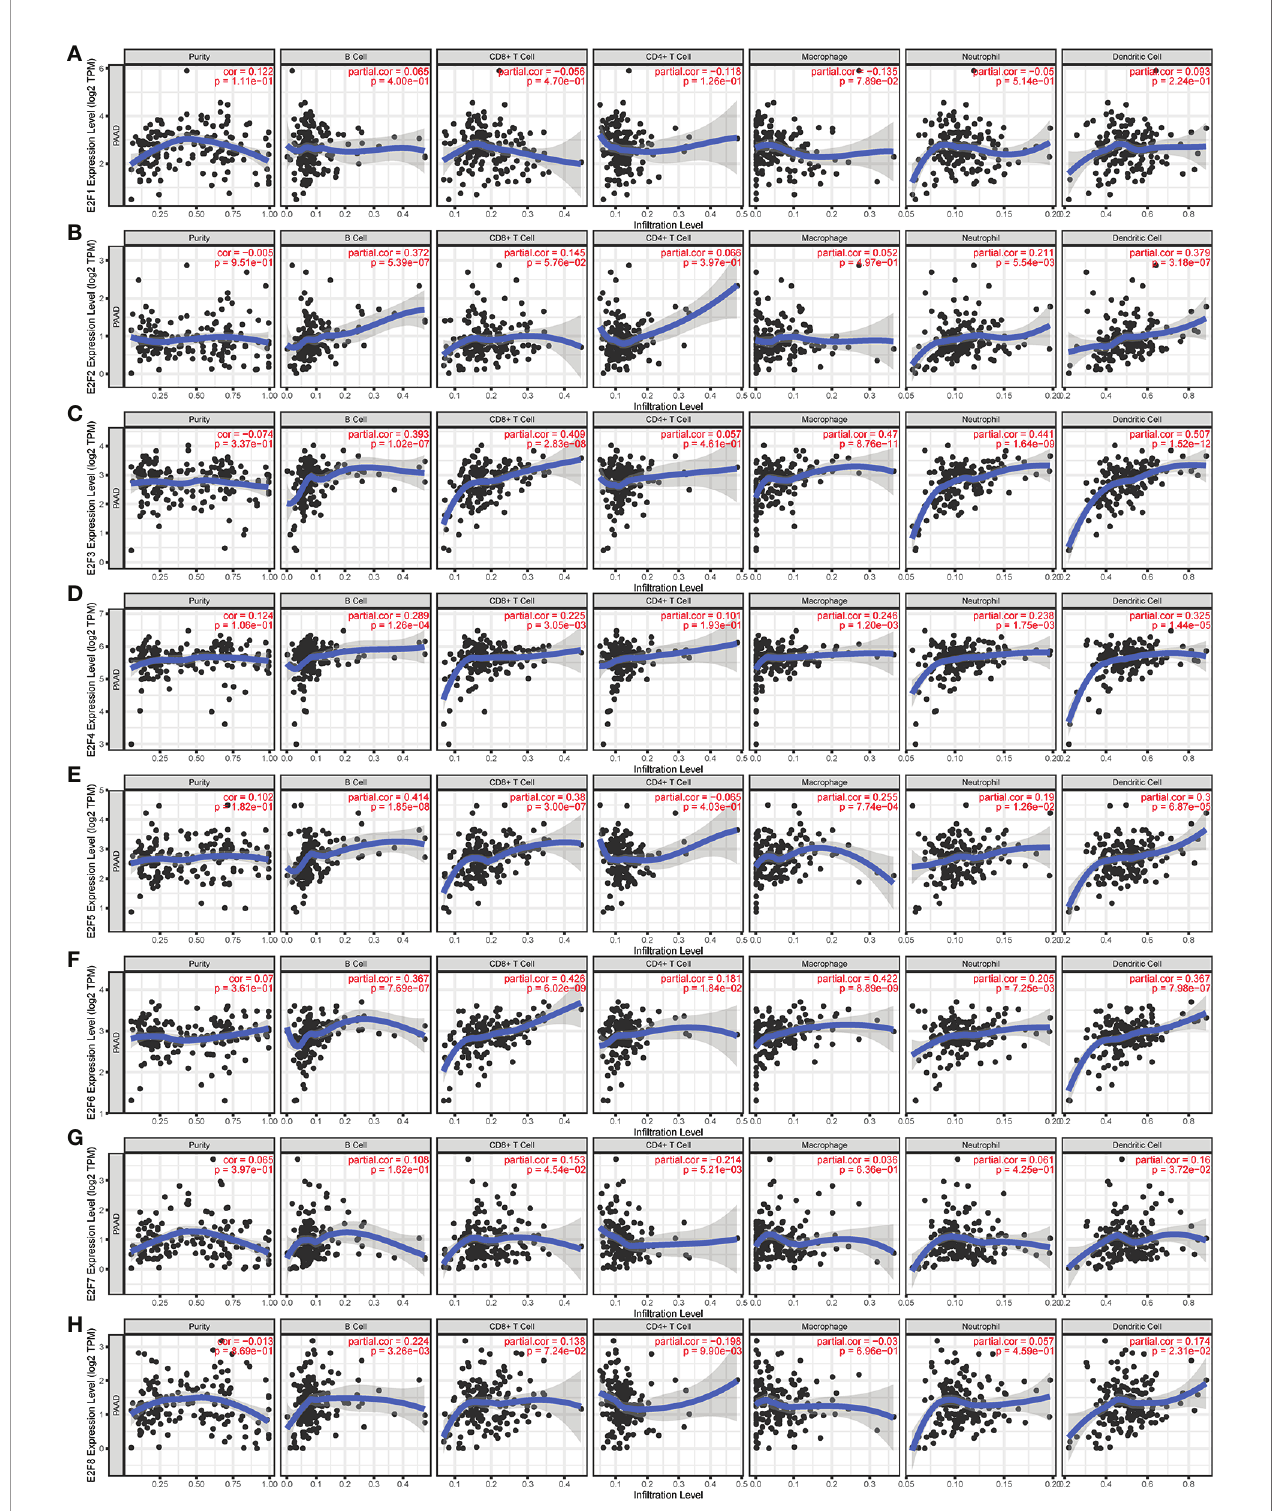
FIGURE 9 | The Relationship between E2Fs Expression Levels and Immune In fi ltration Levels in PAAD (TIMER). The correlation between the abundance of immune cell and the expression of (A) E2F1, (B) E2F2, (C) E2F3, (D) E2F4, (E) E2F5, (F) E2F6, (G) E2F7, (H) E2F8 in